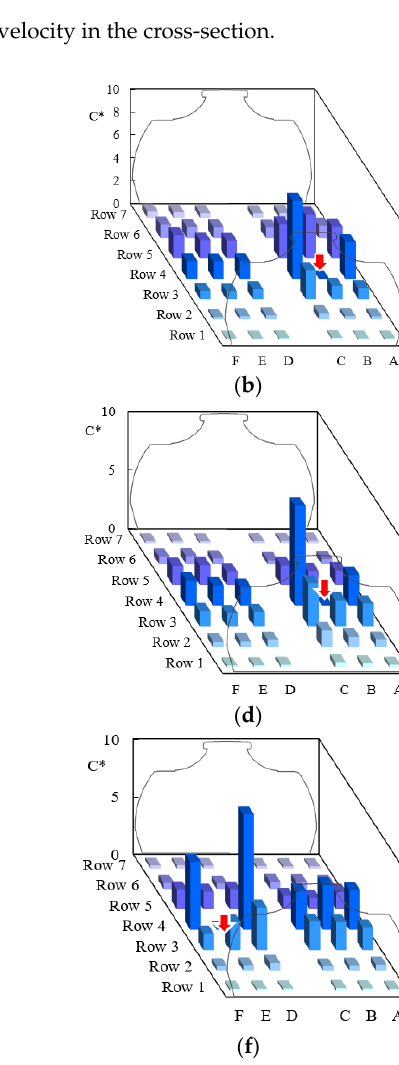
Figure A2. Normalized pollutant concentrations in the respiratory zone of passengers in different